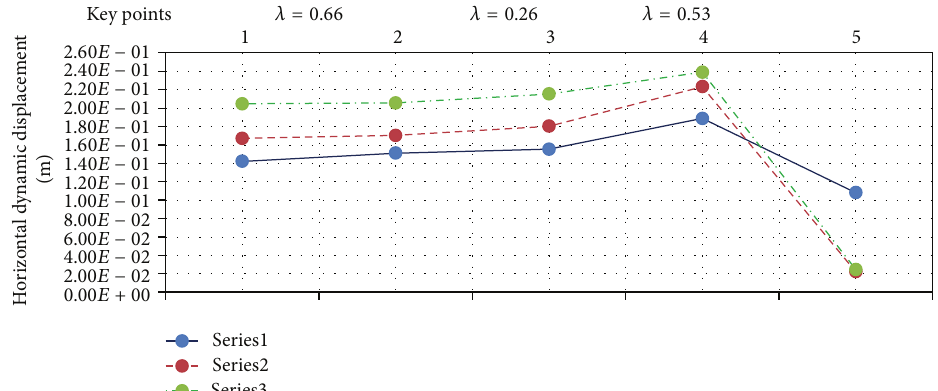
Figure 8: Horizontal displacement at the end of earthquake; horizontal and vertical axes are key points and dynamic displacement (meter).